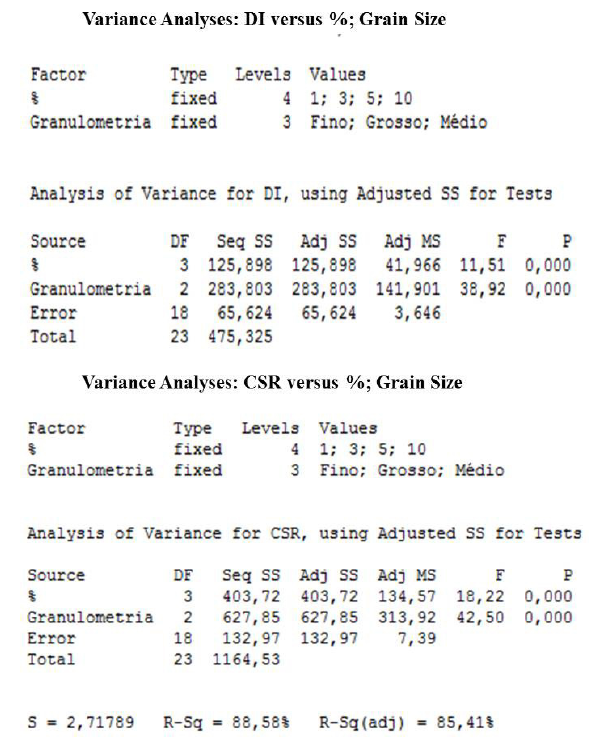
Figure 4. The particle size variance analysis relative to DI150-15 and CSR.